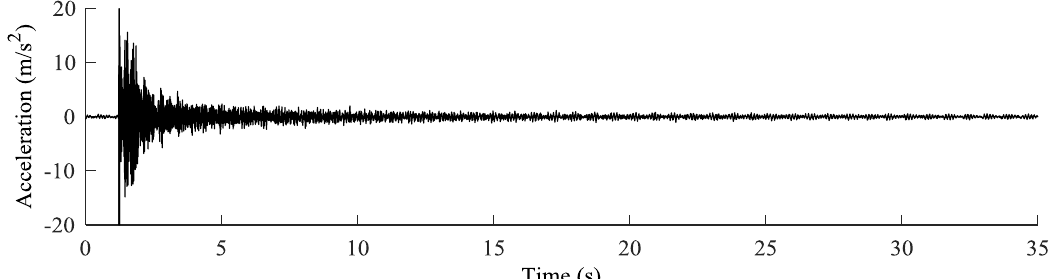
Figure 5. ( a ) Primary and secondary coil of EM sensors are wound around cables; ( b ) the two coils are protected by epoxy covers; ( c ) installation of accelerometers for in situ calibration.